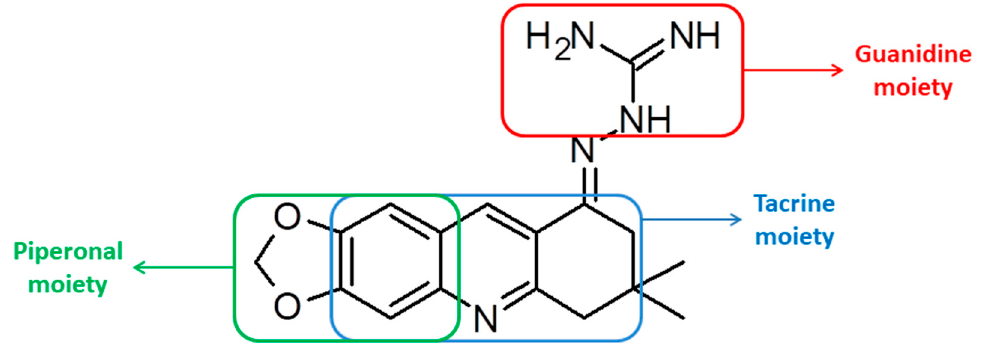
ff erent chemical classes present in the structure of compound (8) Figure 2. Different chemical classes present in the structure of compound (8) . Figure 2. Different chemical classes present in the structure of compound (8) . Figure 2. Di Figure 2. Different chemical classes present in the structure of compound (8) .